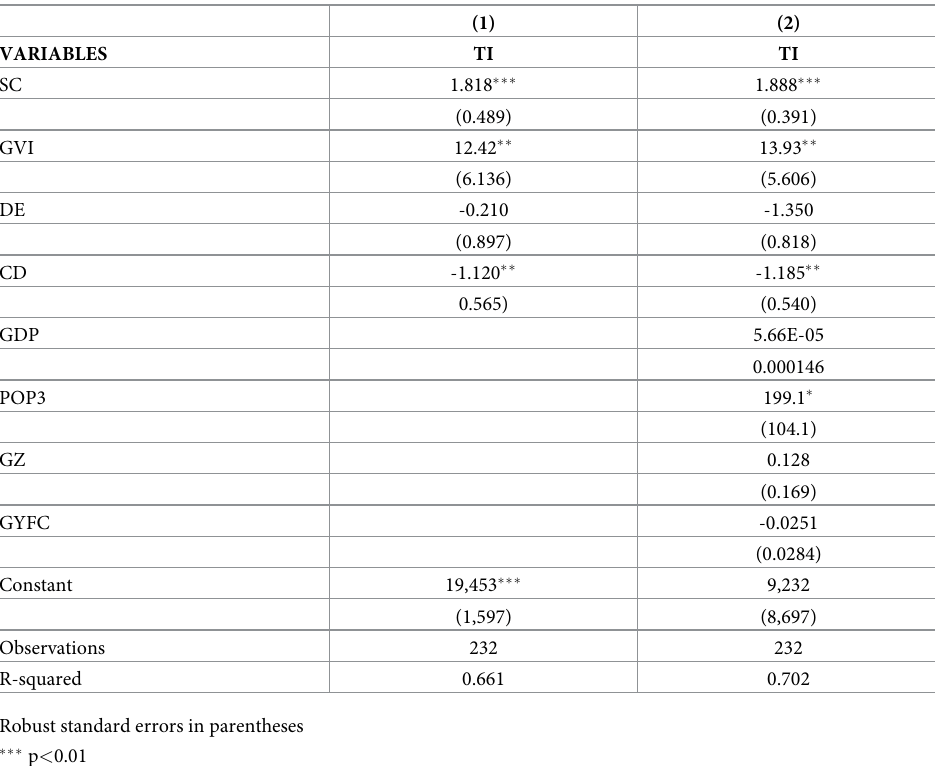
Table 2. Basic regression